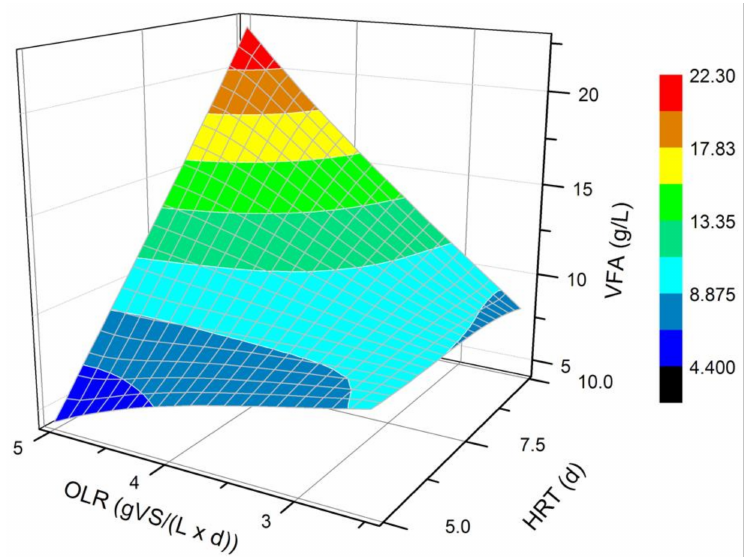
Figure 1. Mean VFA concentration achieved in a steady state of the DF processes carried out at different OLRs (2.5 and 5 gVS/(L × d)) and HRTs (5 and 10